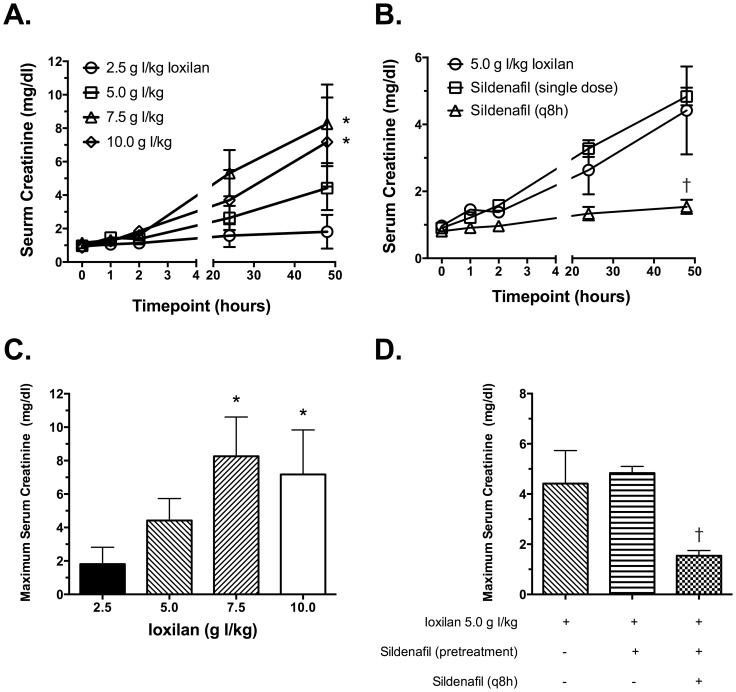
The effects of sildenafil citrate on CM-induced renal dysfunction.Serum samples were prepared from whole blood collected at various time points. Creatinine concentrations were determined using a Luminex xMap assay. (A) Time course of serum creatinine concentration in animals treated with increasing concentrations of CM. (B) Time course of serum creatinine concentration in animals pretreated with sildenafil citrate (6.0 mg/kg; single dose or q8 h) prior to CM exposure (5.0 g I/kg). (C) Maximum serum creatinine concentration in animals treated with increasing concentrations of CM. (D) Maximum serum creatinine concentration in animals pretreated with sildenafil citrate (6.0 mg/kg; single dose or q8 h) prior to CM exposure (5.0 g I/kg). Values are presented as mean ± SEM; n = 3–5. * indicates p<0.05 vs. 2.5 g I/kg and † indicates p<0.05 versus 5.0 g I/kg by one-way ANOVA and Dunnett's multiple comparisons test.